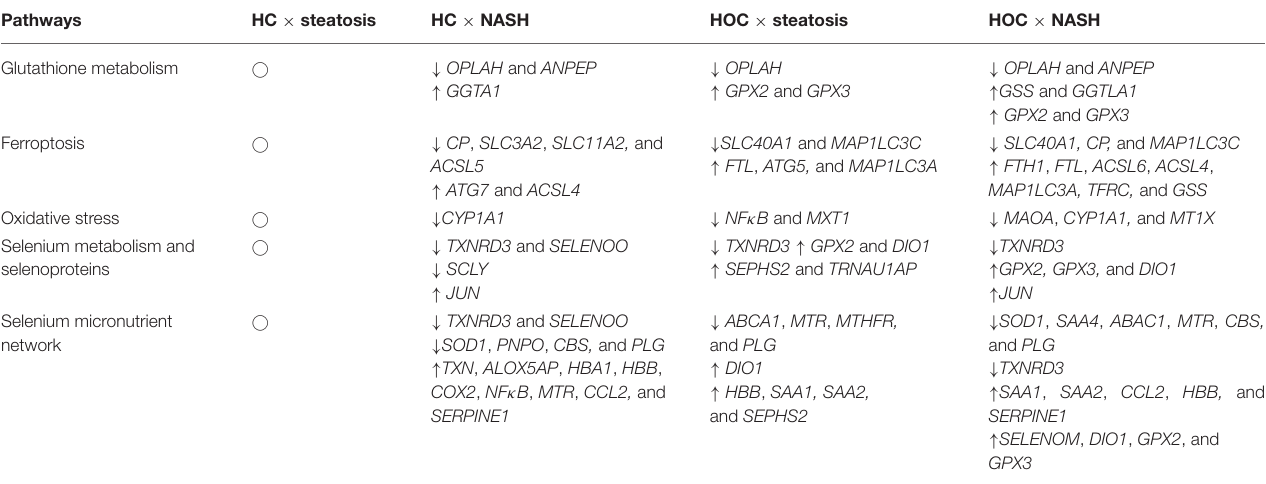
TABLE 2 | Genes of interest in the comparisons normal-weight healthy controls (HC) × steatosis, normal-weight healthy controls (HC) × NASH, healthy obese controls (HOC) × steatosis, healthy obese controls (HOC) × NASH. Pathways HC × steatosis HC × NASH HOC × steatosis HOC × NASH Glutathione